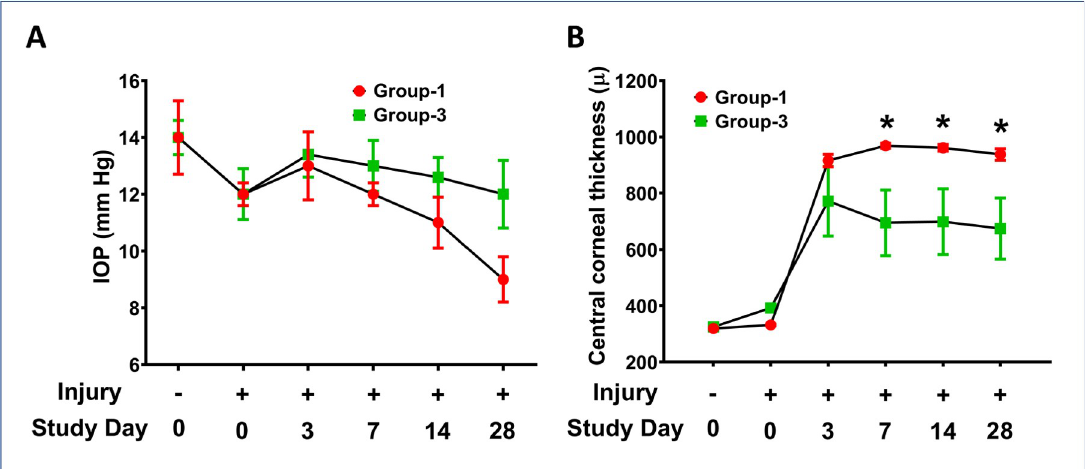
Fig 5. Intraocular pressure and central corneal thickness in wounded eyes -/+ eyedrop. No significant differences in intraocular pressure observed in Group-1 wounded and Group-3 wounded and eyedrop-treated eyes (A). Central corneal thickness was significantly lower in Group-3 wounded and eyedrop-treated eyes at days 7, 14, and 28 (B). (n = 6 for each group; � = p value < 0.05).